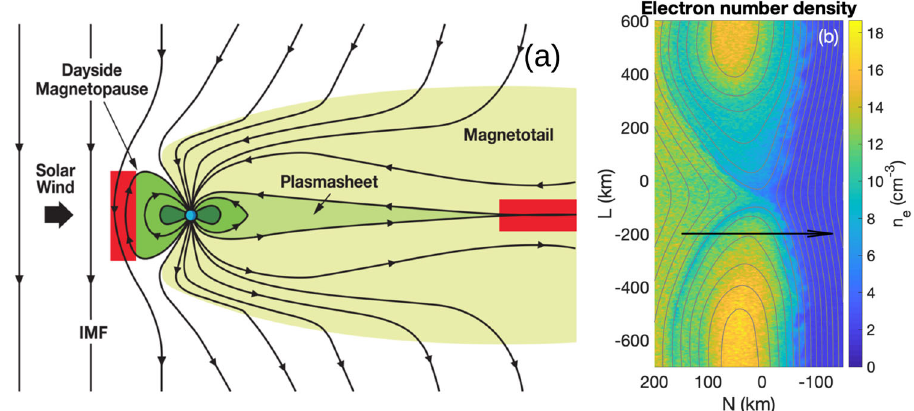
Fig. 1 Magnetic reconnection at the magnetopause. Sketch of the magnetosphere (from https://mms.gsfc.nasa.gov/science.html) and a numerical simulation, showing an overview of a region with lower hybrid waves, anomalous plasma effects, and magnetic reconnection. a Sketch of the magnetosphere around Earth (blue circle) and the regions where magnetic reconnection is expected to occur (indicated by red-shaded regions). The black lines show the magnetic fi eld lines associated with the interplanetary magnetic fi eld (IMF) and Earth's magnetosphere (indicated by the green-shaded regions). The dark green region corresponds to the Van Allen radiation belt region. Magnetic reconnection occurs at the magnetopause, the boundary between higher-density solar wind/magnetosheath and lower-density magnetospheric plasma. b Three-dimensional simulation of magnetic reconnection at the magnetopause (see Methods, subsection Simulation description for details on the simulation parameters). Reconnection at the magnetopause is asymmetric, meaning the upstream conditions on the left and right differ signi fi cantly. The gray lines indicate the magnetic fi eld lines and the color shading indicates electron density n e . Lower hybrid waves at the density gradient drive fl uctuations in n e , which can cause signi fi cant electron diffusion and broadening of the layer, consistent with MMS observations. The black arrow indicates the approximate MMS trajectory through the reconnection event in Fig. 2 based on MMS observations (see ref. 28 ). The parameters used in the simulation are based on this reconnection